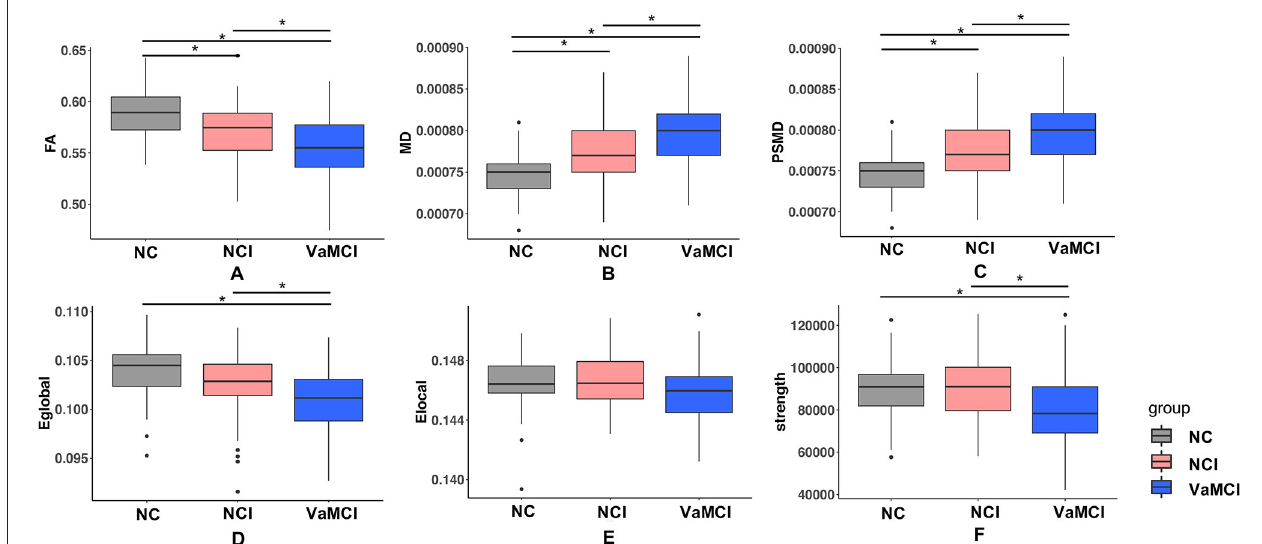
TABLE 2 | Correlation between DTI measures and cognition within non-demented CSVD patients. FA MD PSMD E Global E local Strength r p r p r r p r p MoCA